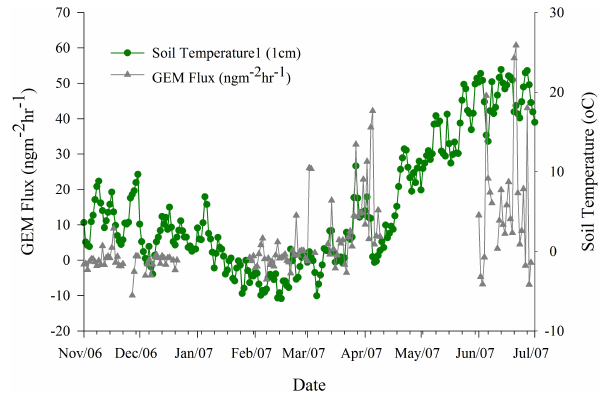
Fig. 10. Daily averages of GEM flux (ngm − 2 hr − 1 ) and soil mois- ture content (%) with time (1 November 2006 to 29 June 2007) measured at Elora Research Station,